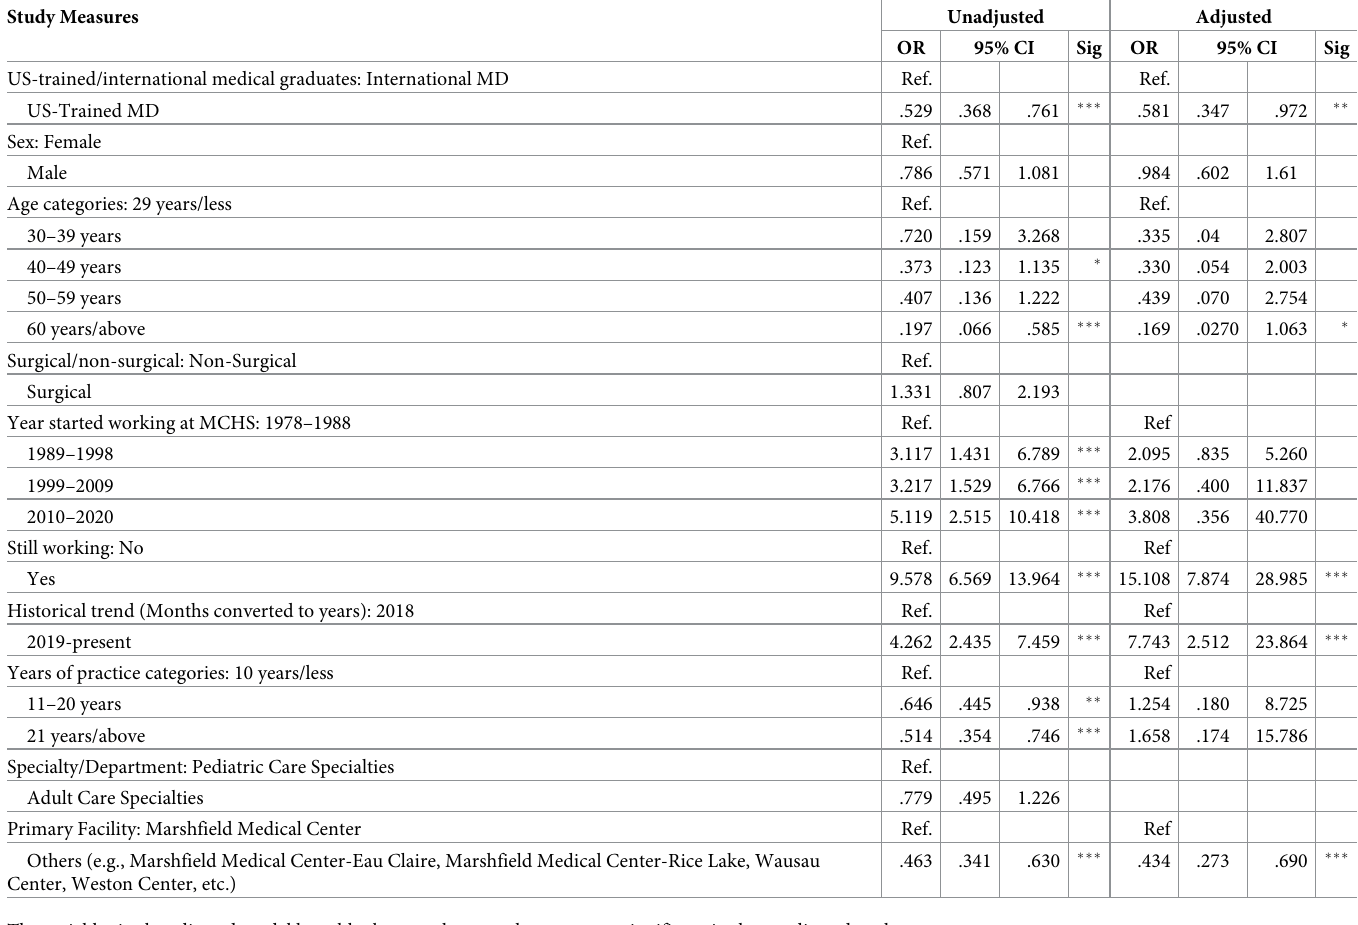
Table 4. Unadjusted and adjusted analyses of user and institutional factors influencing VR uptake (study outcome) among MCHS physicians,